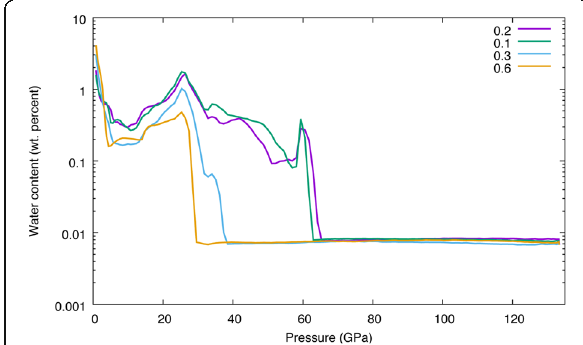
Fig. 9 1D horizontally averaged mantle water content varying with the friction coefficient of the yield strength of the oceanic lithosphere as a function of pressure scaled as GPa